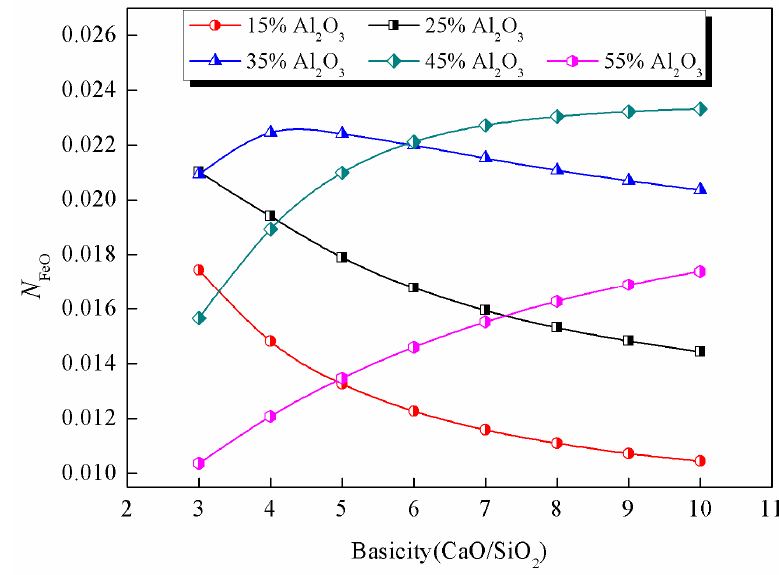
Figure 4. Effect of Al 2 O 3 content on the optimal alkalinity.